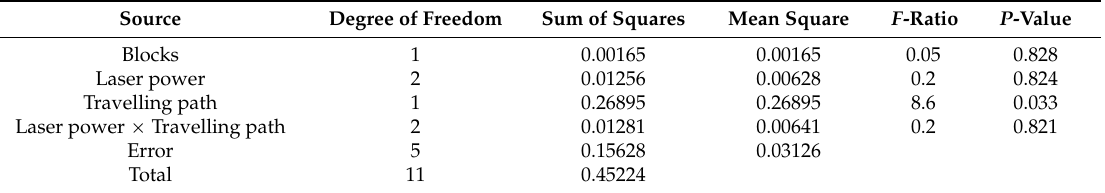
Table 8. ANOVA table for experiment #1-1 (2-kW fiber laser welding system).